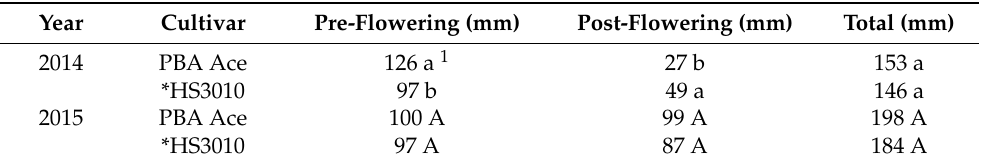
Table 1. Water use averaged over CO 2 treatments in lentil in 2014 and 2015 in the Australian Grains Free Air CO 2 Enrichment (AGFACE) facility.